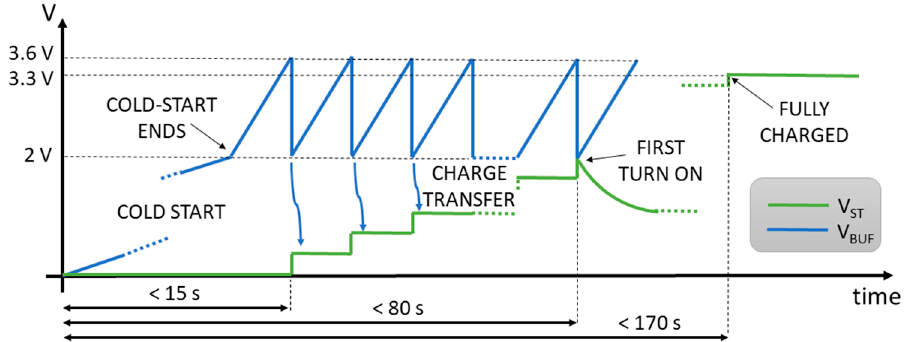
Figure 6. Mechanism to efficiently manage charging of a fully depleted storage capacitance. The reported values are referred to the real case scenario described in Figure 11.